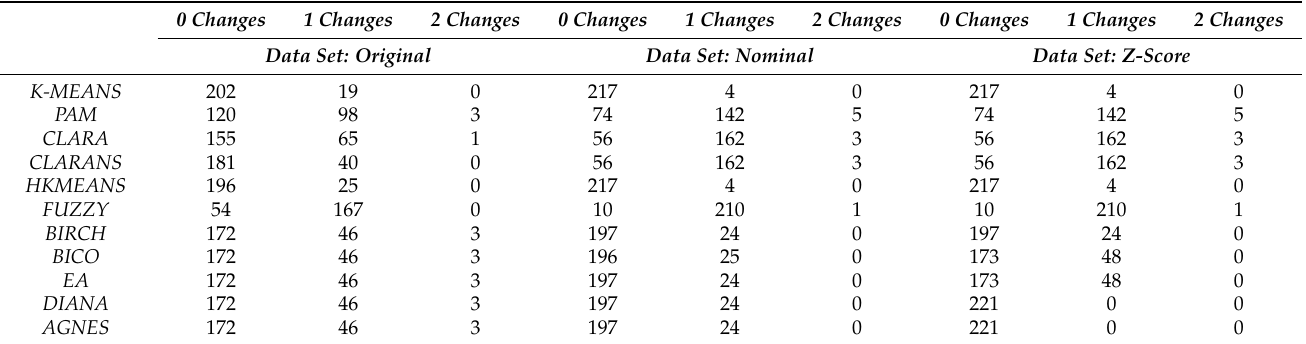
Table 4. Measurement of the number of cases that vary between clusters to study the variability of